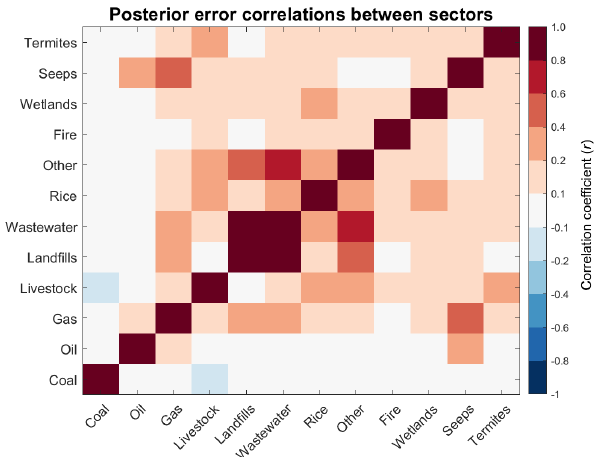
Figure 6. Error correlation coefficients ( r ) between posterior esti- mates of methane emissions from different source sectors in China. Error correlations measure the ability of the inversion to separate emissions between sectors ( ± 1 = not at all; 0 = fully). “Other” is a combination of minor anthropogenic emissions including indus- try, stationary combustion, mobile combustion, aircraft, compost- ing, and field burning of agricultural